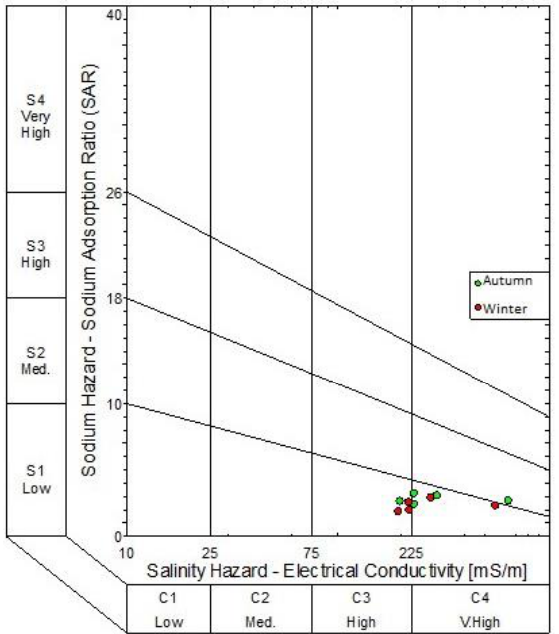
Figure 7. Salinity hazard (SAR) diagram for the boreholes in the northern landfill site.